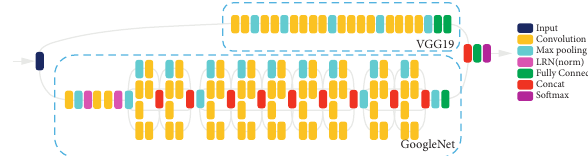
Figure 2: Architecture of the proposed LCNNE model.